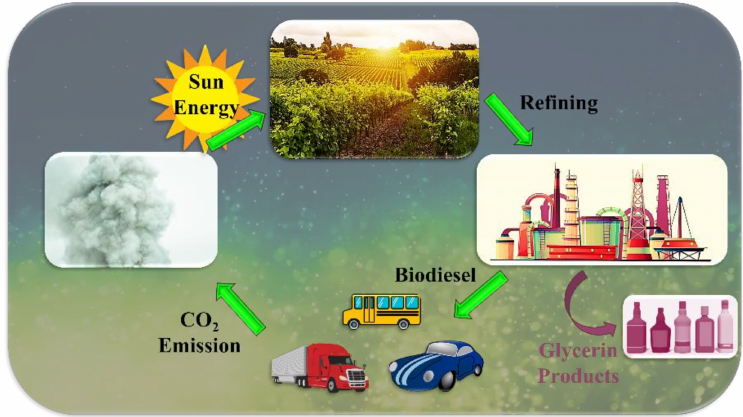
Figure 2. Closed carbon cycle for Biodiesel (adapted from